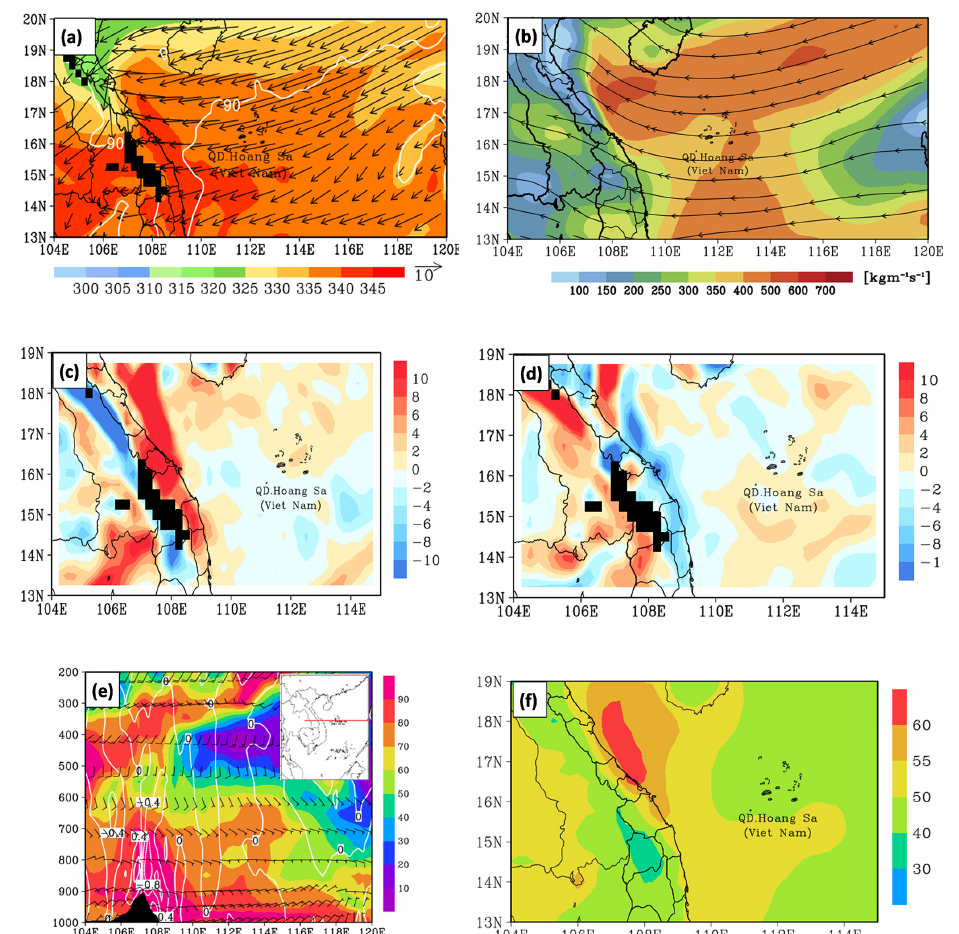
Figure 9. (a) The ERA5 θ e (K, shaded), horizontal winds (ms − 1 , vector), and relative humidity (%, white contours, every 30%) at 925hPa. The black areas are where the 925hPa level is below the ground. (b) Surface and 200hPa vertically integrated moisture flux (kgm − 1 s − 1 ). (c) The moisture convergence/divergence ( × 10 − 4 , gkg − 1 s − 1 , shaded, positive for convergence) at the 925hPa. The blacked areas are where the 925hPa level is below the ground. (d) The moisture convergence/divergence ( × 10 − 4 , gkg − 1 s − 1 , shaded, positive for convergence) at the 850hPa. The blacked areas are where the 925hPa level is below the ground. (e) East–west vertical cross-section along 16 ◦ N (see insert) of vertical motions (Pas − 1 , white contours), relative humidity (%, shaded), and horizontal winds (ms − 1 , vector). The topography is black shaded. (f) Precipitable water between surface and 200hPa